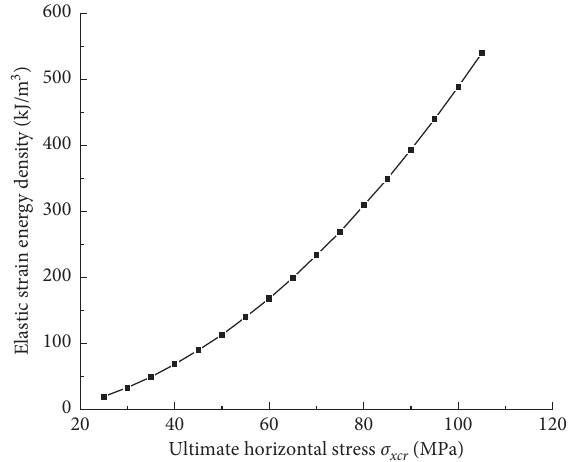
Figure 4: Curves of the elastic strain energy density for different values of horizontal stress.